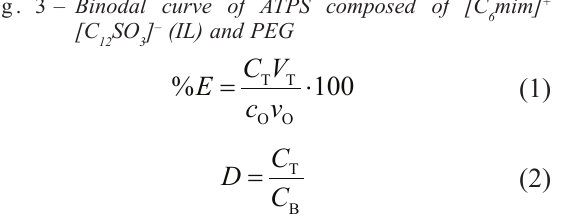
Fig. 3 – Binodal curve of ATPS composed of [C